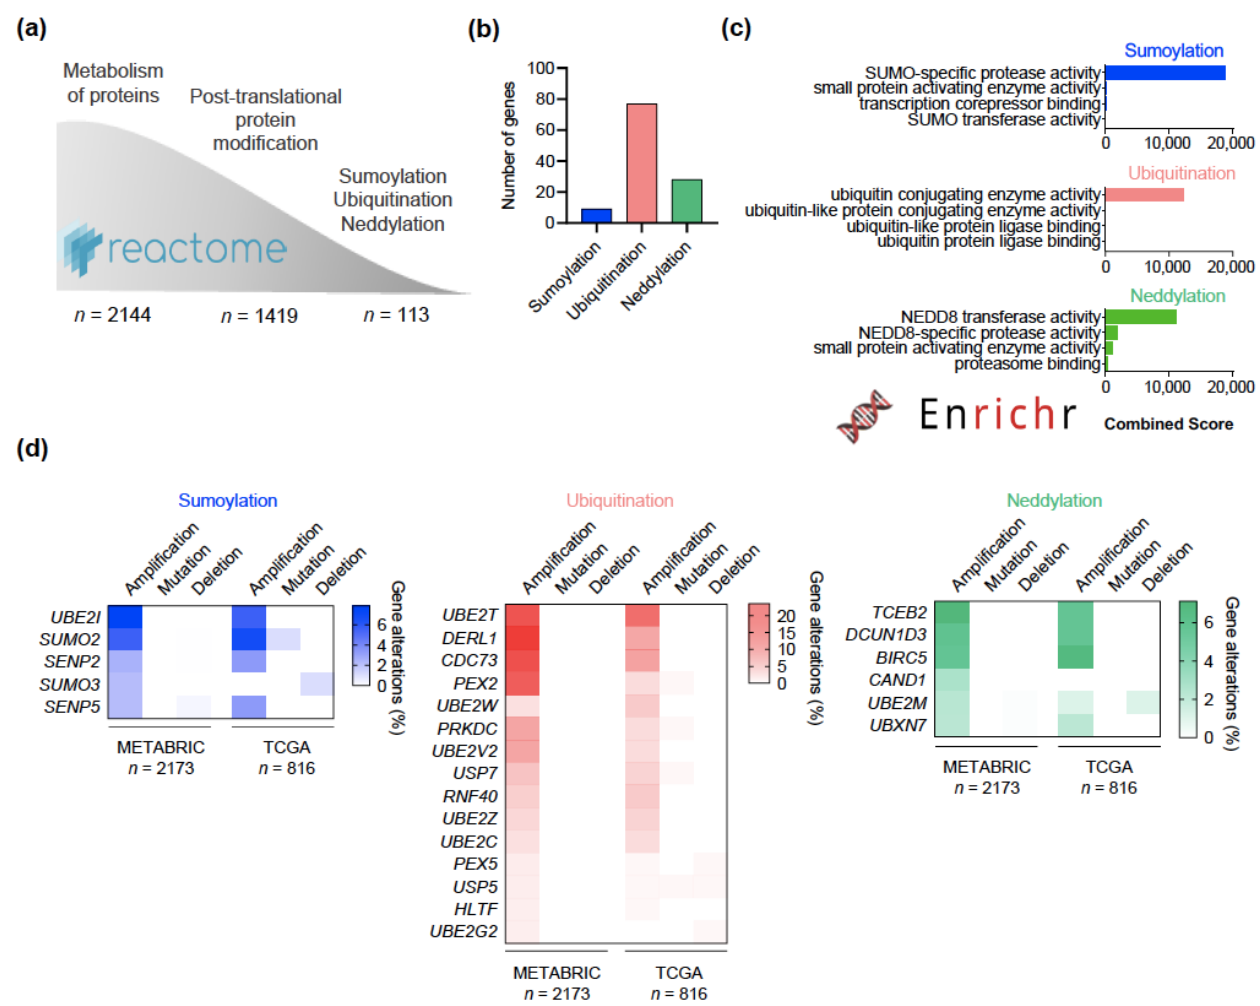
Figure 1. Common genomic alterations in ubiquitination, SUMOylation, and neddylation in breast cancer. ( a ) Flow chart showing the interrogation of the Reactome database to identify genes involved in post-translational protein modifications, particularly ubiquitination, SUMOylation, and neddylation. ( b ) Bar graph summarizing the number of genes participating in each process. Only UCHL3 participated in both ubiquitination and neddylation. ( c ) Bar graph showing the GO molecular function of the genes previously identified for each process, sorted by the combined score in the EnrichR database. ( d ) Heatmap presenting the frequency of patients from the TCGA and METABRIC datasets with amplifications, mutations, and deletions, of the genes involved in each process. Only genes with a frequency of amplifications higher than 2% are displayed, those under 2% can be found in Figure S1.